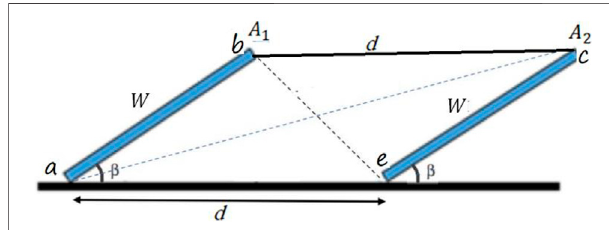
FIGURE 1 | De fi nition of the crossed-strings method for two surfaces of in fi nite length.